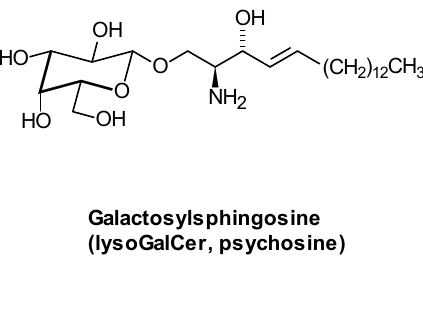
Figure 10. Structure of Galactosylsphingosine, a toxic substance that accounts for the pathogenesis of Krabbe disease (GalCer-  -galactosidase deficiency, Globoid cell